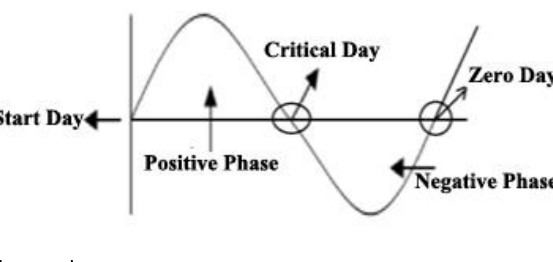
Fig. 1. Different parts of biorhythm